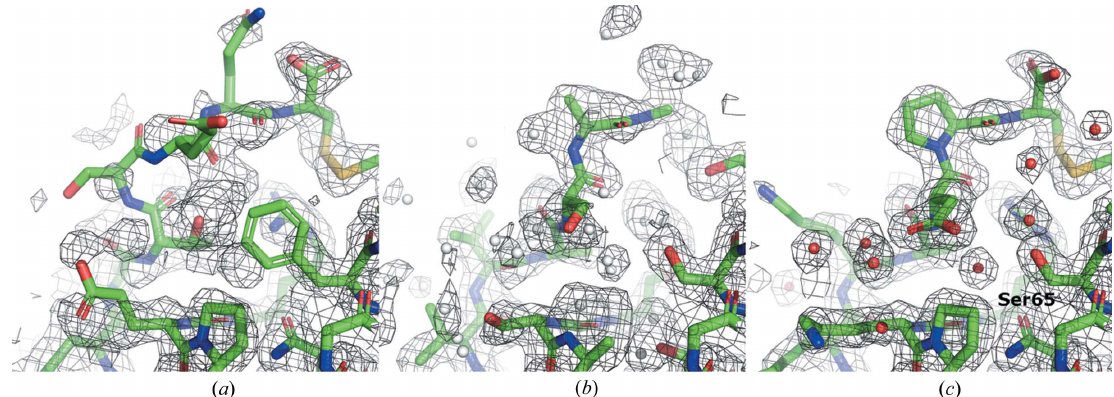
Figure 6 Consecutive steps of crystal structure determination and sequence identification of a protein with hemolytic activity purified from B. atrox venom. ( a ) Initial MR solution after 30 REFMAC5 refinement cycles with jelly-body restraints. The same fragment in ( b ) the ARP/wARP model re-traced without an input sequence and used as an input for findMySequence , and in ( c ) the final model. The 2 F o (cid:3) F c maps are contoured at the 1 (cid:3) level above the mean. The free atoms used for sparse electron-density map representation in ARP/wARP are shown as grey spheres. Water molecules are shown as red spheres.